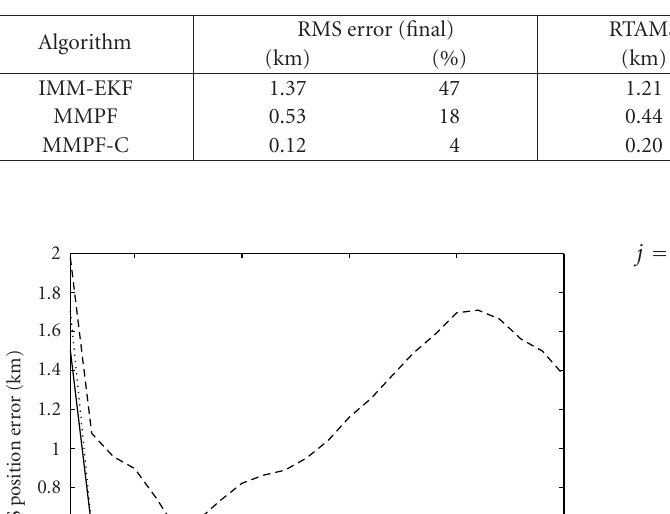
Table 3: Performance comparison for tracking with hard constraints.